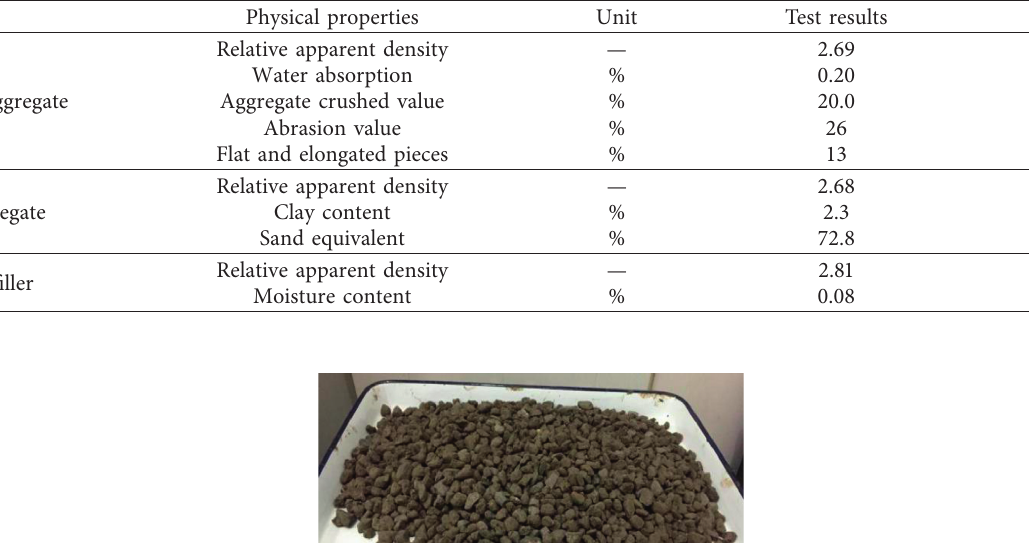
Table 2: Properties of aggregate and mineral filler.